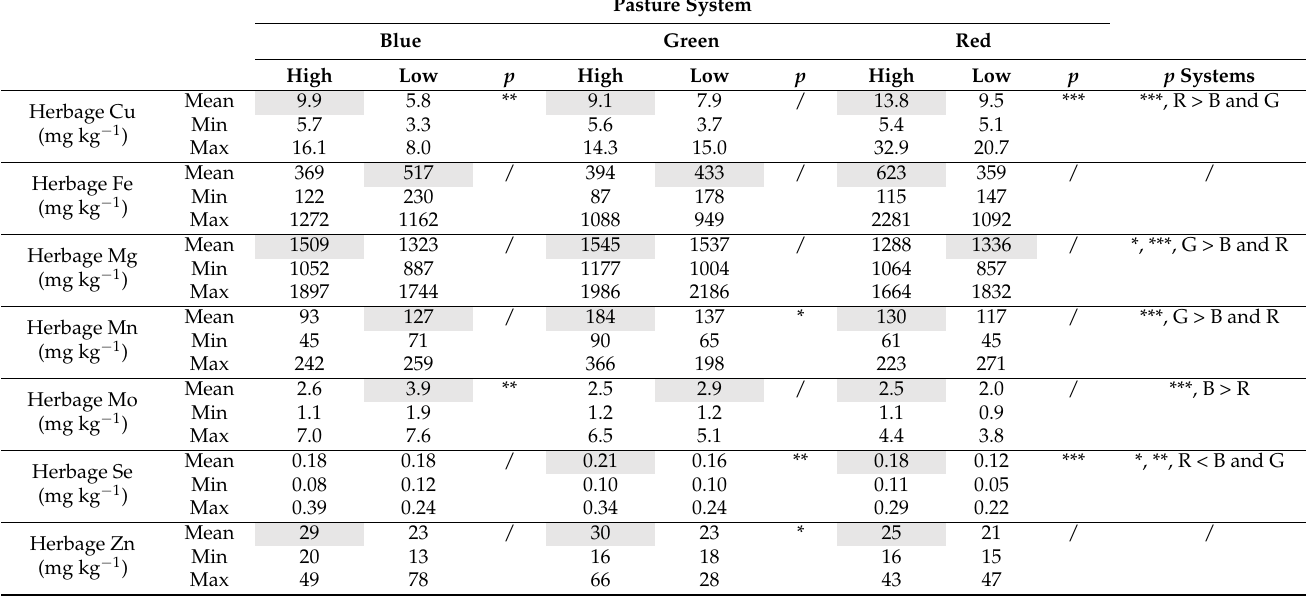
Table 4. Mean, minimum and maximum herbage micro-nutrient concentration at points selected as high or low soil total micro-nutrient content; 8 high and 8 low points in each of the pasture systems: high-sugar grass + legume mix − N fertilizer (blue/HSG + L), permanent pasture + N fertilizer (green/P + N), high-sugar grass + N fertilizer (red/HSG + N). p = significance between high and low sites and between systems: * = p < 0.05, ** = p < 0.01, *** = p < 0.001. Grey highlight = highest